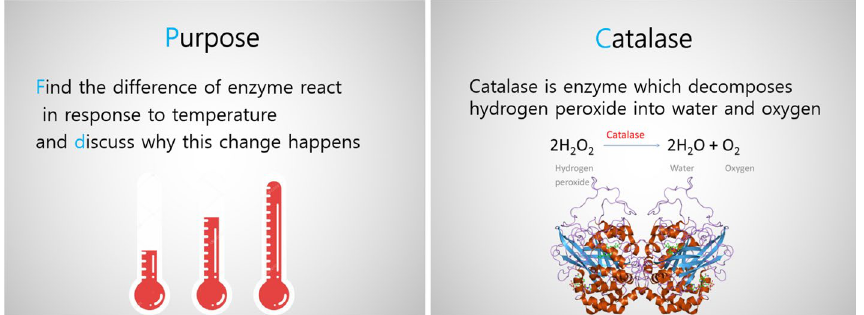
Fig. 2 Jaemin’s use of L2 and images for the international exchange program